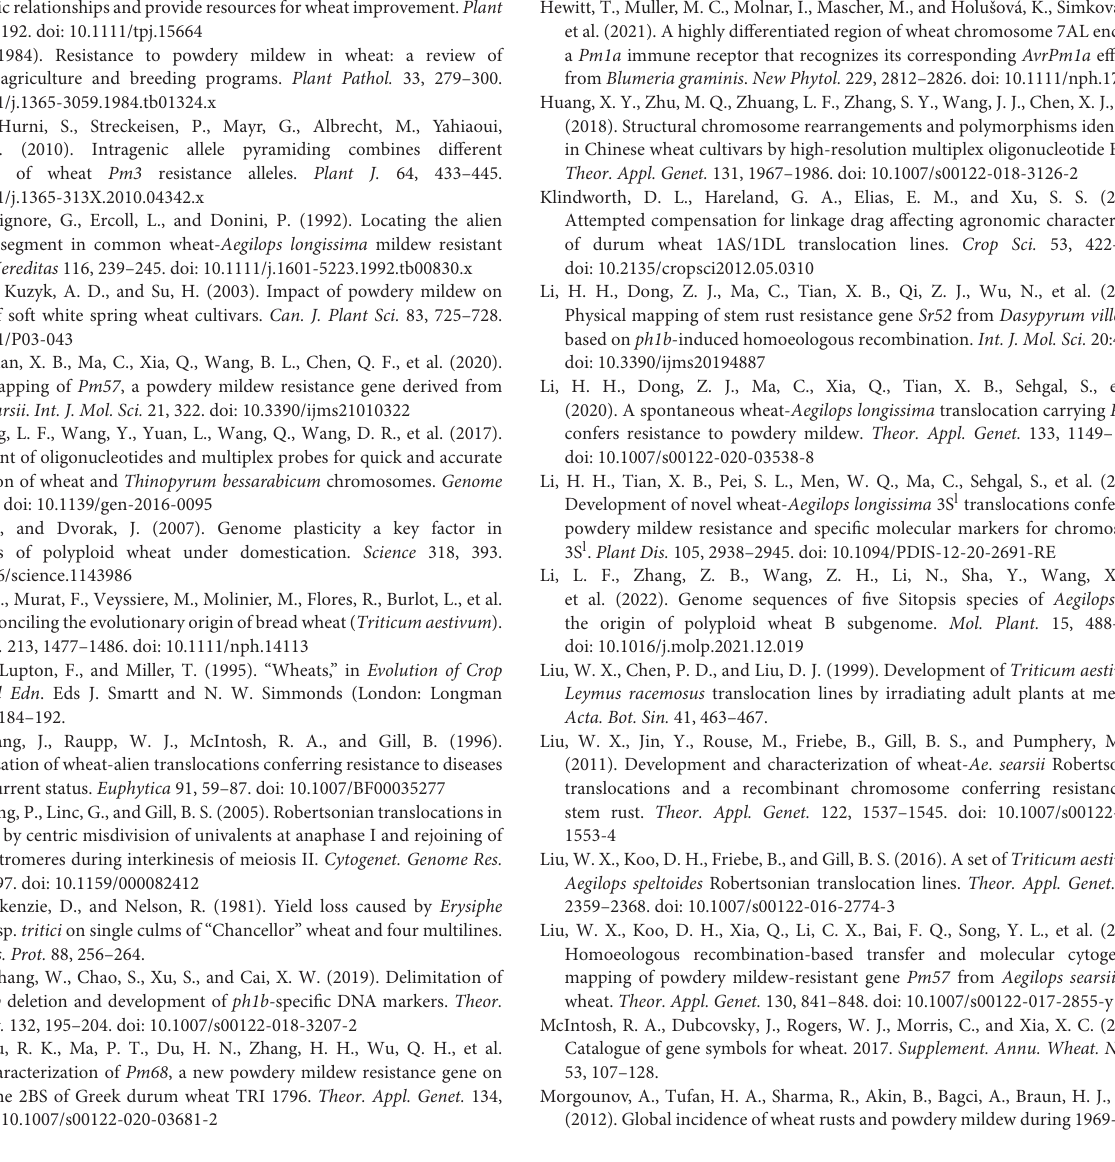
numbers on the right of 6A and 6B columns represented chromosome fragment length (FL). Based on analyses of SSR markers and 6S l #3-specific markers, T31